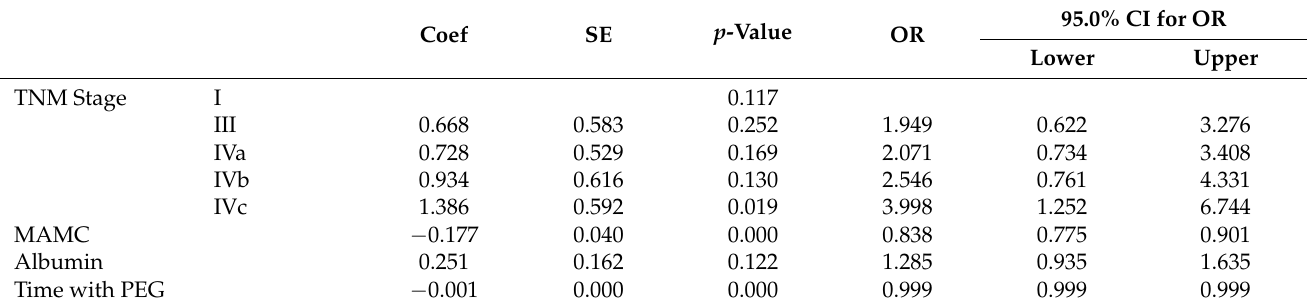
Table 6. Cox regression analysis.